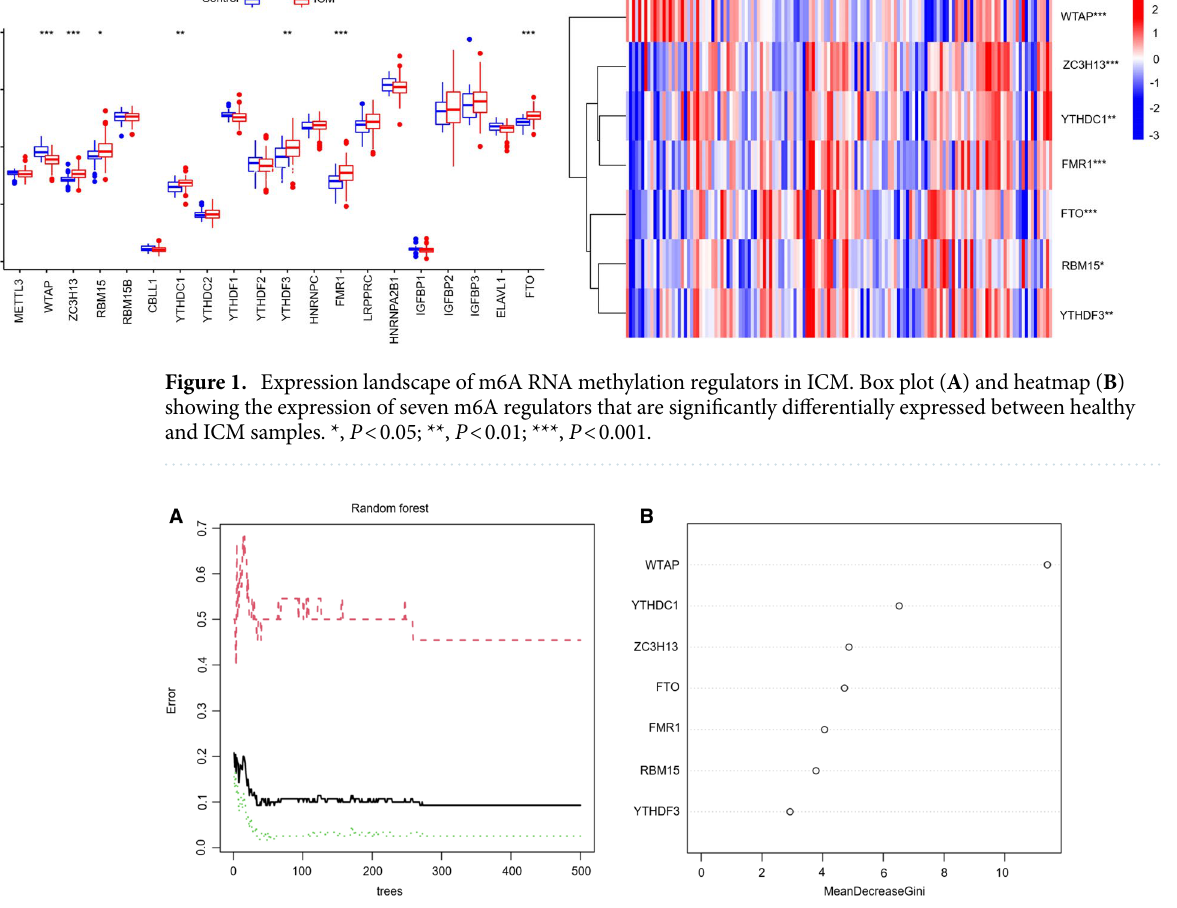
Figure 2. Random forest model construction to identify the key m6A regulators. ( A ) The influence of the number of decision trees on the error rate. The x-axis represents the number of decision trees, and the y-axis indicates the error rate. When the number of decision trees was approximately 300, the error rate was relatively stable. ( B ) Results of the Gini coefficient method in the random forest classifier. The x-axis indicates genetic variables while the y-axis represents the importance